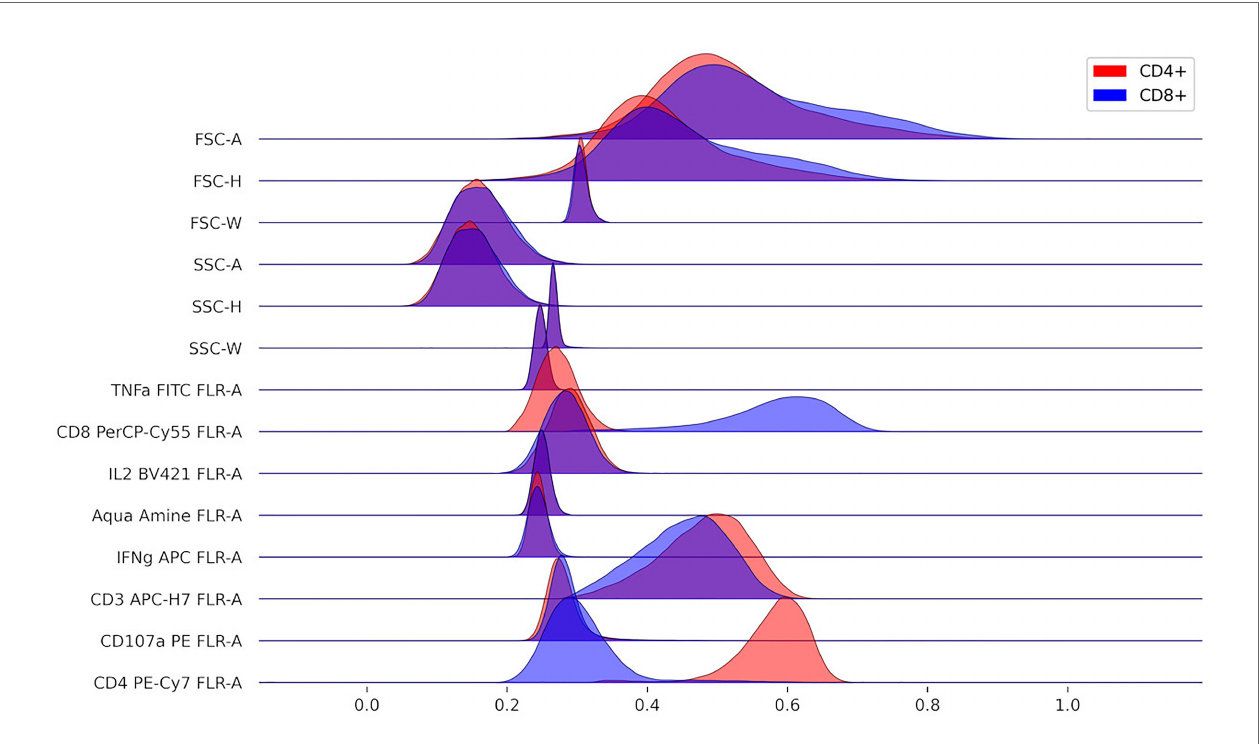
FIGURE 2 | Comparison of marker distributions across CD4+ and CD8+ T